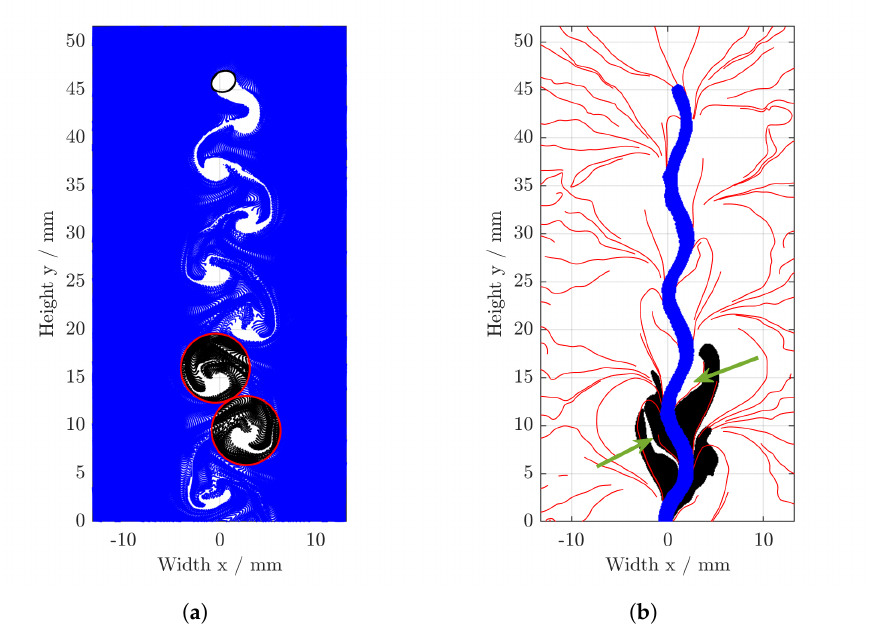
Figure 8. Approximate identification of the parcels transported into the wake in the case of the ellipsoidal bubble. ( a ) Parcels (black) in two approximated vortices (red circles) at t = 0.524 s. ( b ) Parcels transported into two vortices (black) and repelling LCS (red lines) for τ ∈ [0 s, 0.524 s] at t = 0 s. The initial positions of the black parcels are bound by the repelling LCS. Green arrows point out areas, from which parcels are assumed to be transported into the wake as well. Blue parcels were removed from the analysis due to nonphysical behavior (therefore excluded in ( a